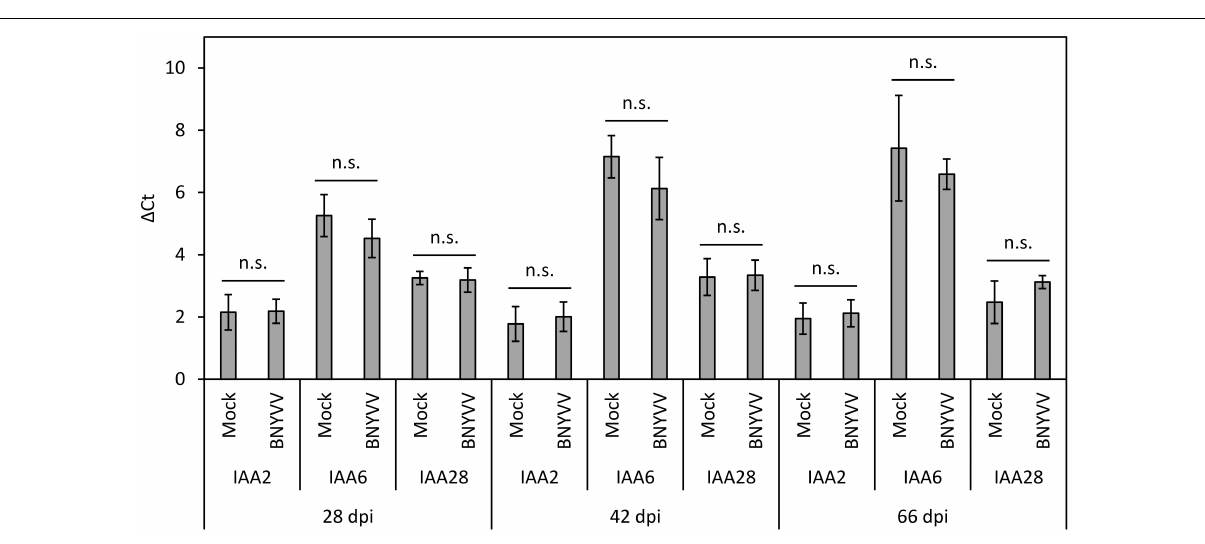
FIGURE 6 | Expression level of BvIAA2 , BvIAA6 and BvIAA28 in BNYVV mechanically infected sugar beet roots compared to the expression in non-inoculated (mock) sugar beet roots. The roots were analyzed at 28, 42, and 66 dpi. Horizontal bars indicate significance (n.s. = not significant) and vertical bars indicate standard deviation ( n =